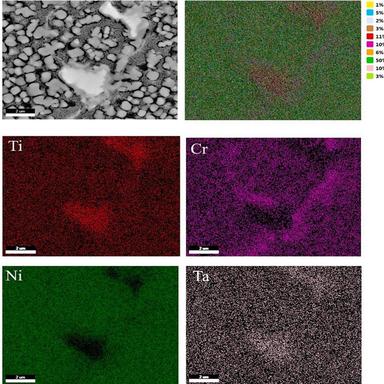
The SEM micrograph and EDS Map of the decomposed MC during long-term operation (55,000 h).